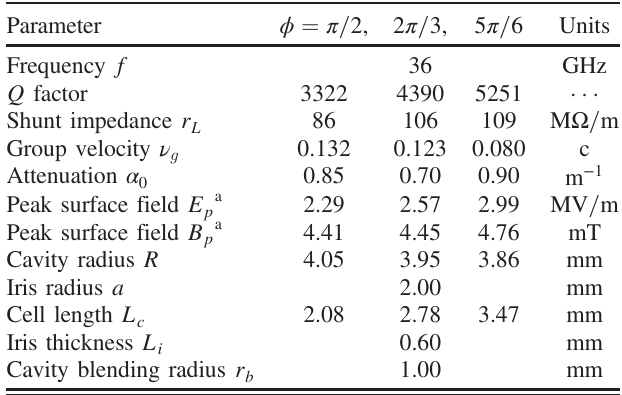
FIG. 12. Integrated voltage for a 30-cm long reentrant structure and 15 MW of input power.